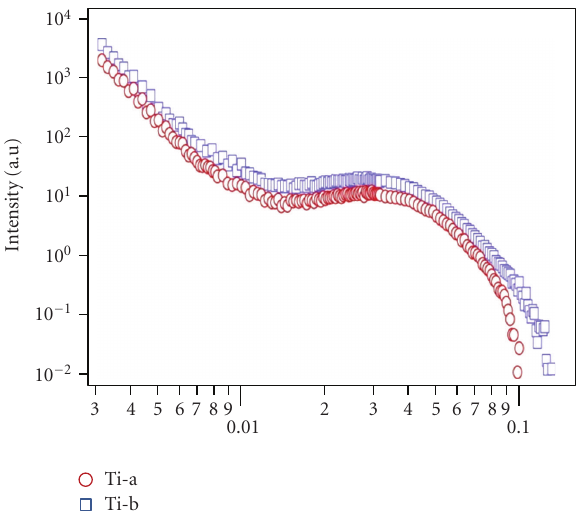
Figure 3: Small-angle Neutron (SANS) patterns of nanoporous TiO 2